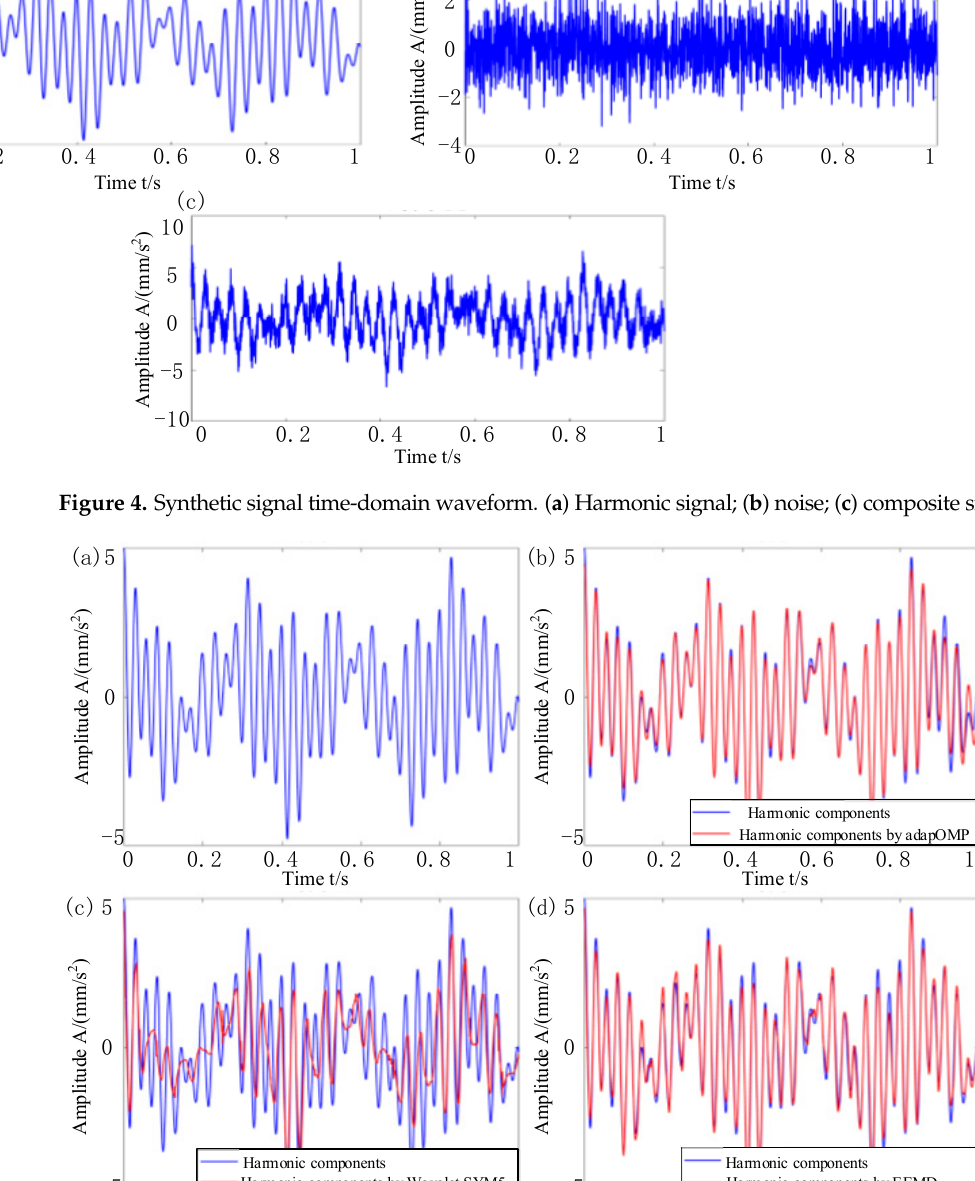
Harmonic components by Wavelet SYM5